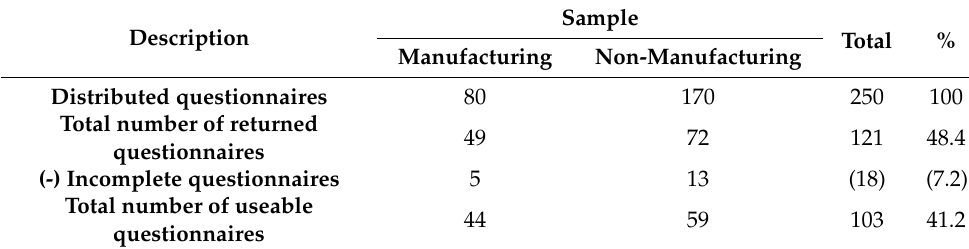
Table 2. Response rates.